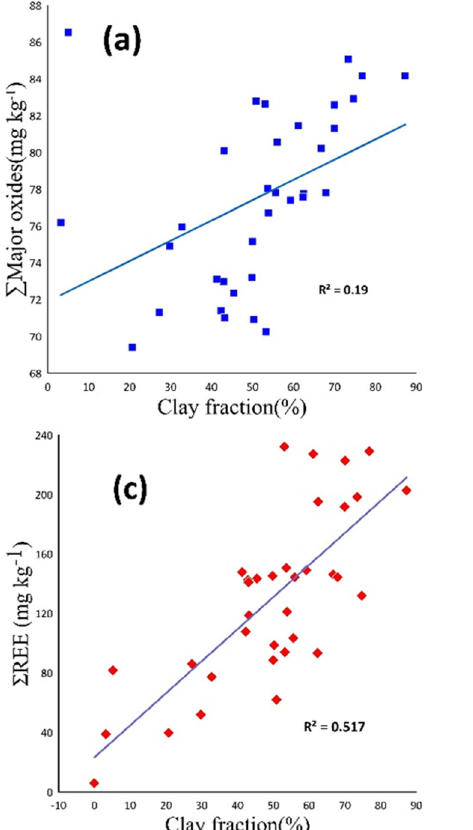
with the results of Rao et al. [45] and Gulcin and Alwasel [46], who found that the amount of REEs increases when the particle size decreases and when the proportion of clay com ‐ ponents increases. 4.2. Organic Matter (OM) Distribution and pH in Soils In order to investigate the relationship between the proportion of organic matter and the pH value with the element distribution in the soils, correlation coefficients were de ‐ termined. As shown in Table 7, organic matter plays an important role in the distribution of the metals in the studied soils. The positive correlation between Al and K could be due to the high proportion of illite in the clay minerals ([47], Table 2). Most trace elements were also positively correlated with OM (r > 0.5; Table 7), while rare earths showed an even stronger correlation with OM, with correlation coefficients ranging from 0.63 to 0.67 (Ta ‐ ble 7). Cao et al. [48] found that as soil pH increases, the bond strengths between rare earths and organic complexes become stronger [49].